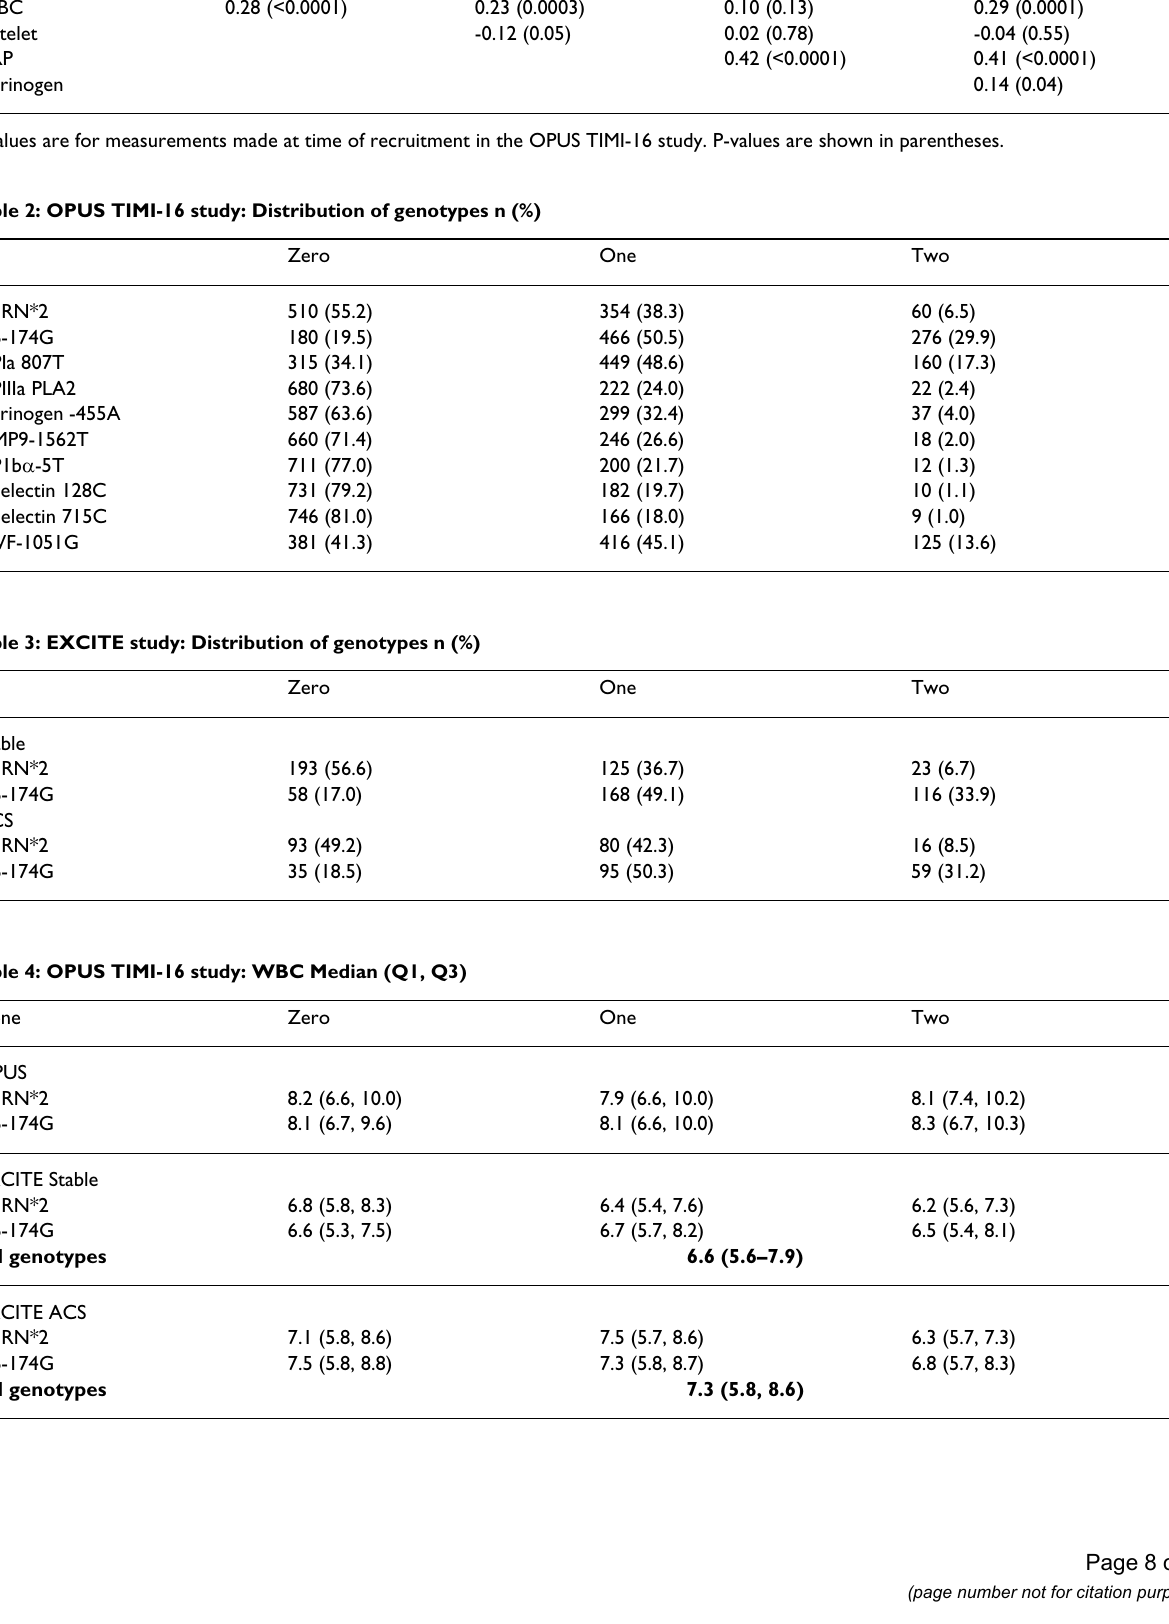
Table 1: OPUS TIMI-16 study: Correlations (r) among White Blood Cell count (WBC), Platelet count, C-reactive protein (CRP), Fibrinogen protein and troponin T. Platelet CRP Fibrinogen Troponin T WBC